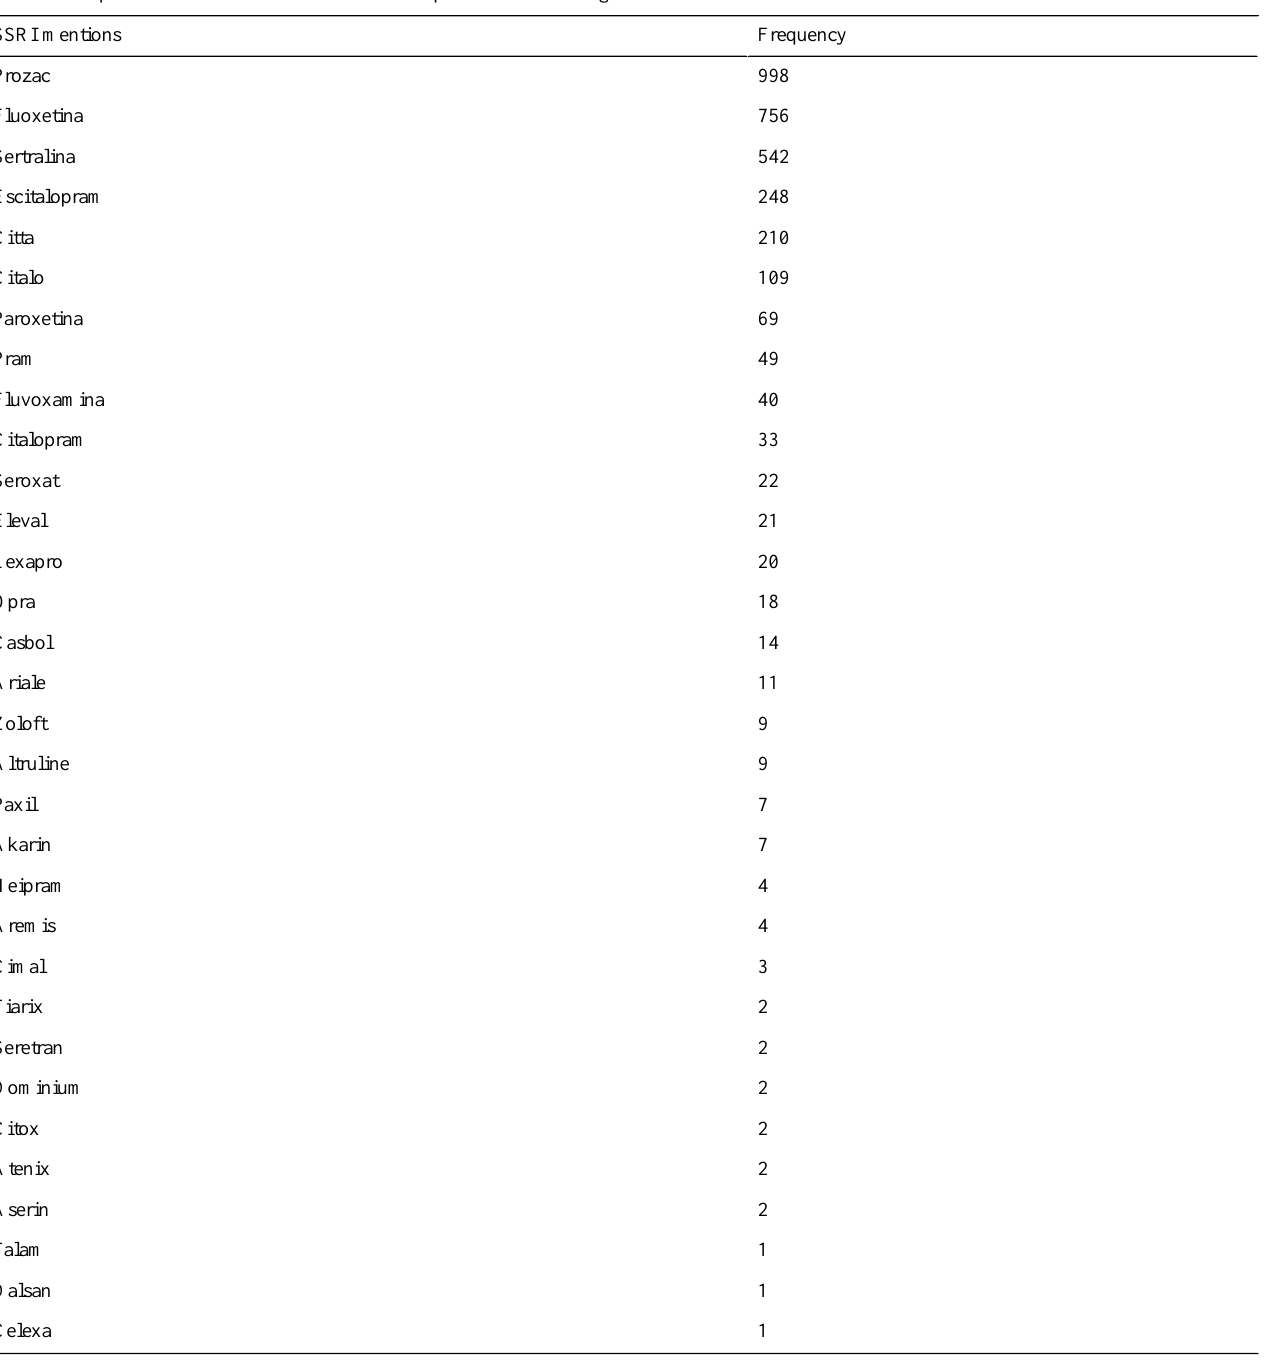
Table 2. Frequencies of SSRI names mentioned in Spanish tweets during November